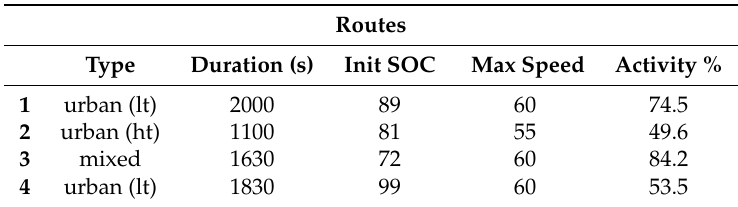
Table 1. Itineraries used for training and